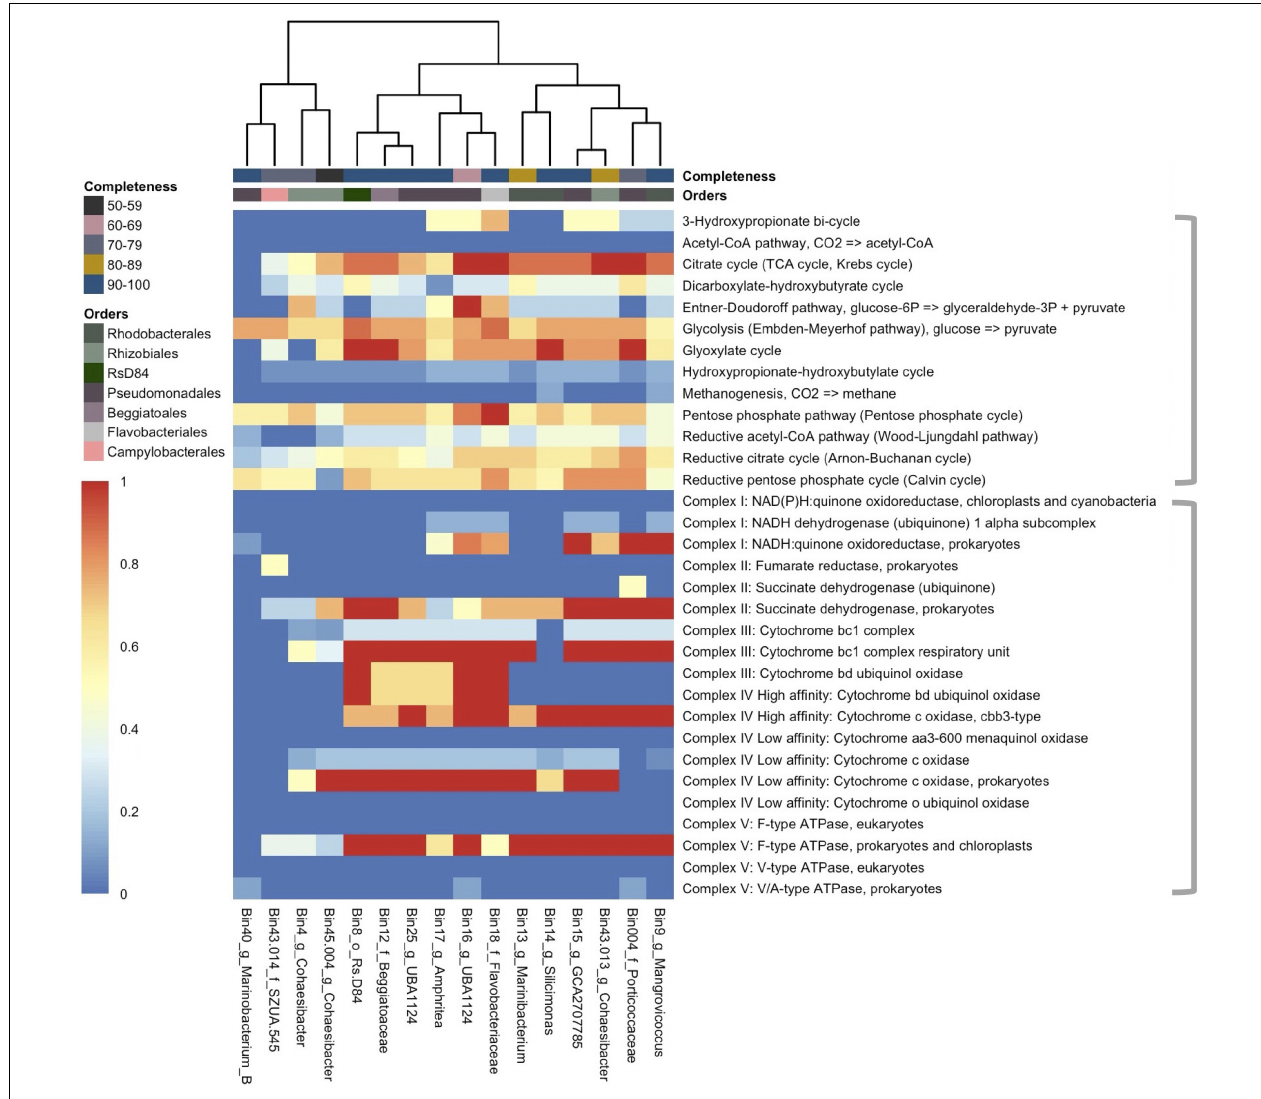
FIGURE 4 | The coverage of common metabolic pathways and electron transport chain complexes across 16 metagenome-assembled genomes (MAGs). The heatmap represents the completeness of each module with “1” (red) indicating a complete module and “0” (deep blue) indicating that the module is not present. The heatmap is split by gray brackets. The top bracket encompasses major metabolic functions and the bottom brackets encompass electron transport chain complexes. The MAGs ( x -axis) are labeled by bin number and the lowest taxonomic assignment designated. The x -axis is hierarchically clustered by Euclidean distance among the pathways present in each MAG (bottom) and colored (as in Figure 3 ) by the respective bacterial order and by genome completeness of the MAGs (top) .